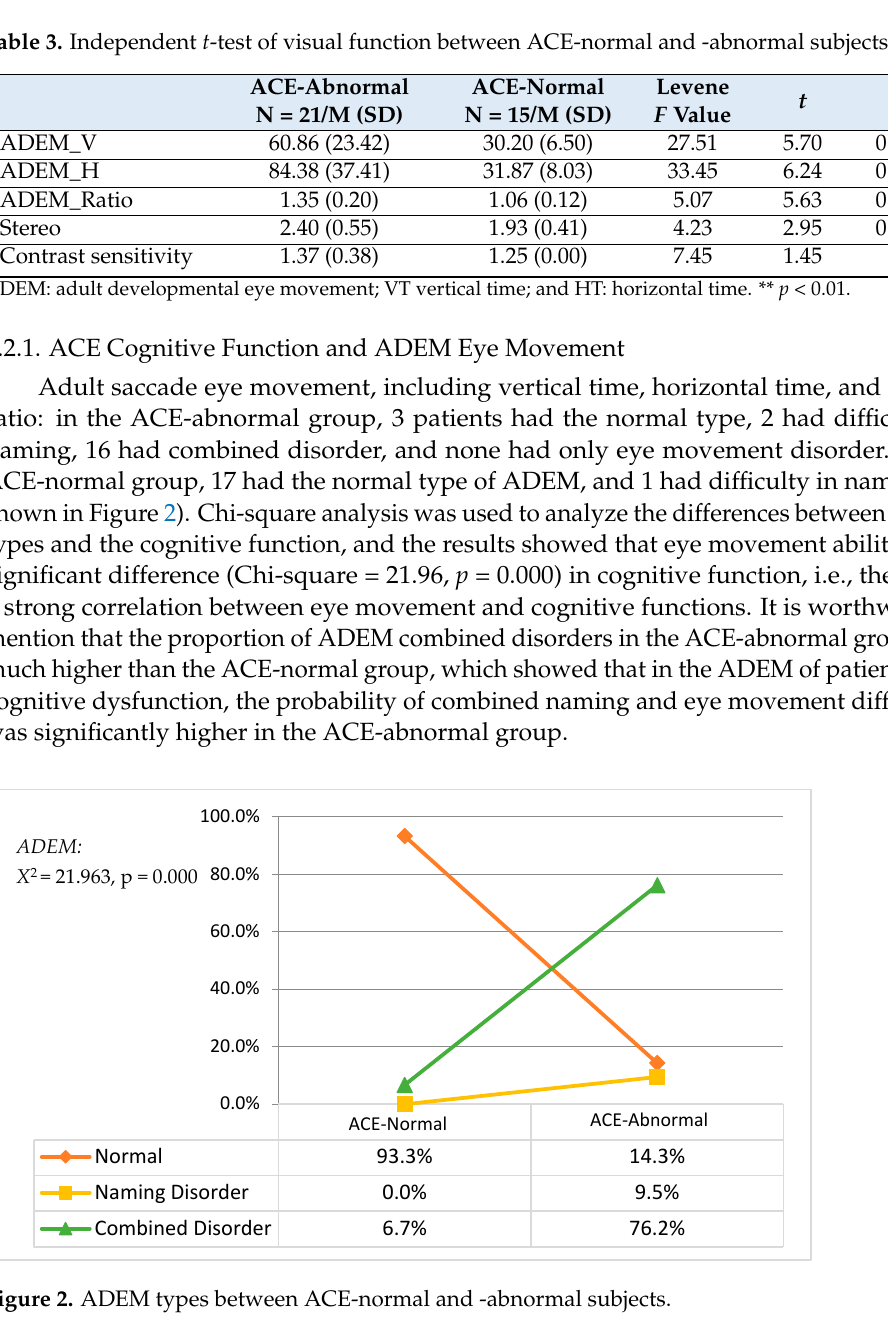
Figure 3. Distance phoria and near phoria between ACE-normal and -abnormal subjects. 3.3. Indicator for Cognitive Function 3.3.1. Linear Regression Analysis on Significant Variables According to the analysis above, there were significant differences between normal and abnormal cognitive groups in macular pigment, retinal thickness, eye movement abil- ity, and stereopsis. If the ACE total score was taken as the dependent variable, and macu- lar pigment, retinal thickness, eye movement ability, and stereopsis were all taken as in- dependent variables for linear regression analysis, the results showed that ADEM hori- zonal, stereopsis, and retinal thickness (outer layer, inferior quadrant) had a high ability